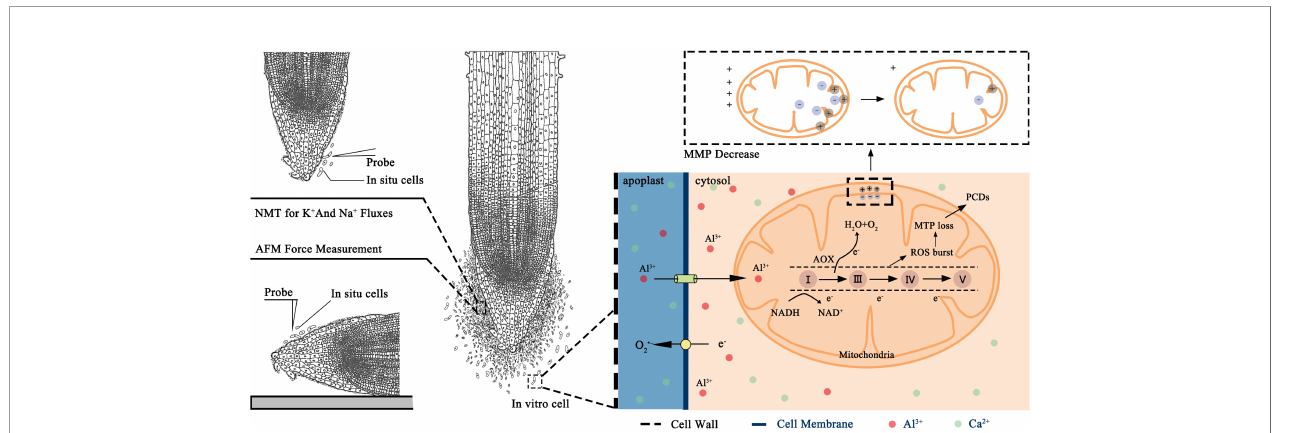
FIGURE 2 | Schematic diagram of mechanism of response system of root border cells under Al toxicity